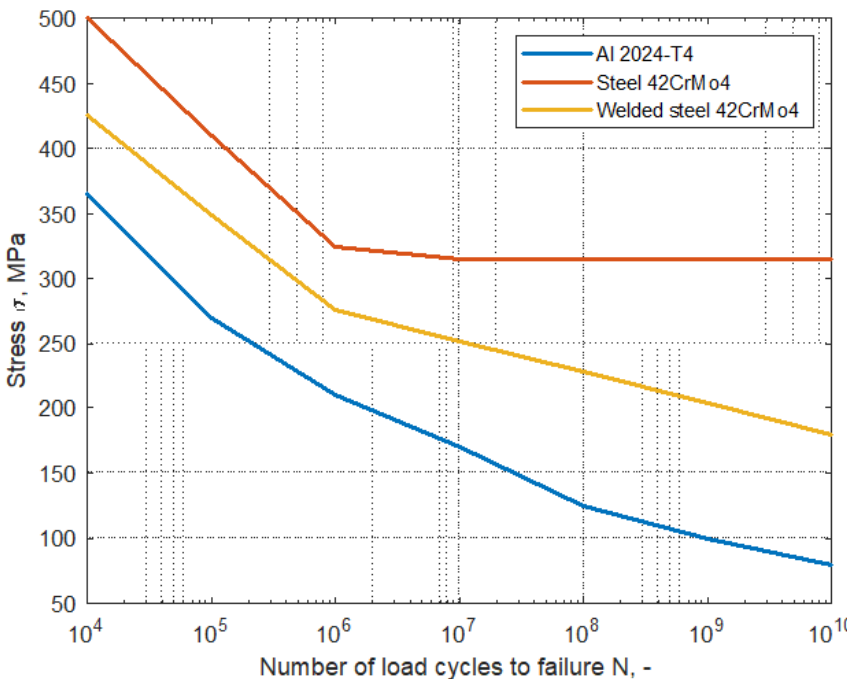
Figure 1. Example of S-N curves for 2024-T4 aluminum, 42CrMo4 steel and arc-welded for the same steel, based on [25] and private